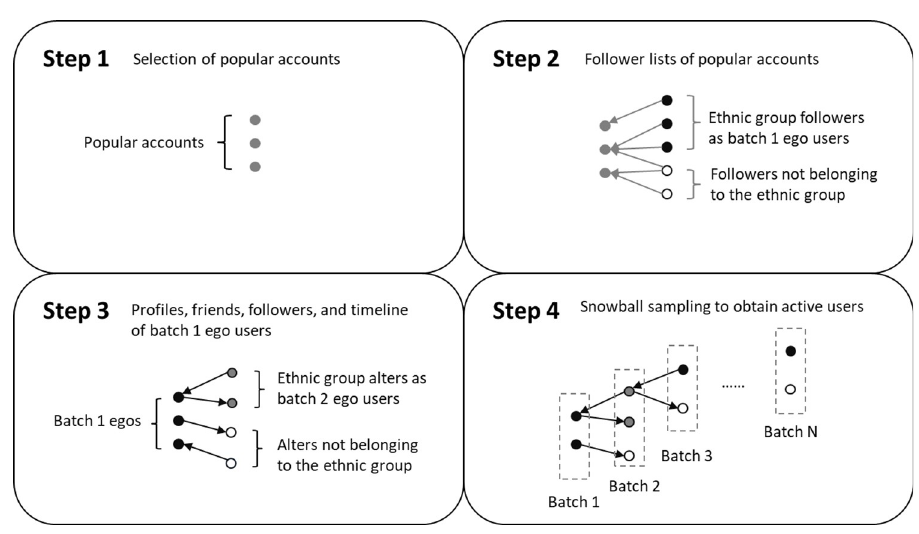
Fig 1. An illustration of the data collection